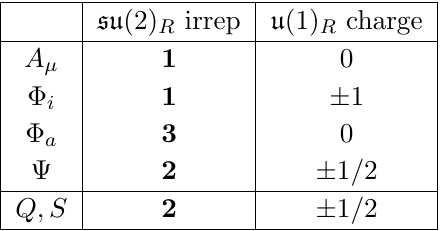
Table 1. R-symmetry quantum numbers of the various (cid:12)elds that appear in the Lagrangian as well as of the